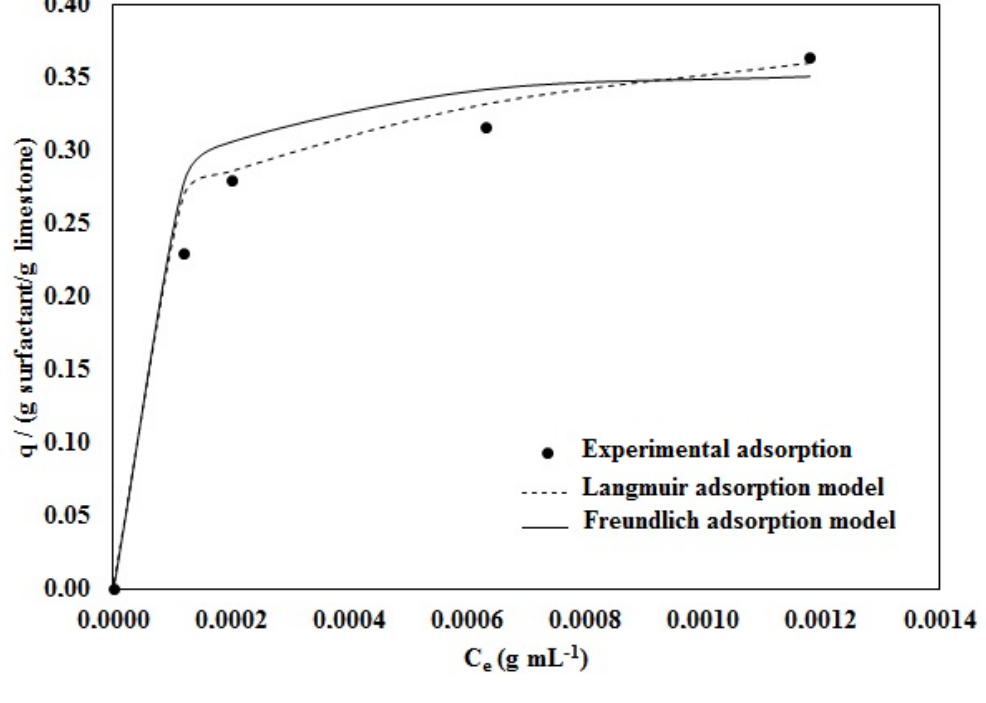
Figure 3. Langmuir and Freundlich adsorption isotherms for the SCO solution (3 g L −1 ) at 50